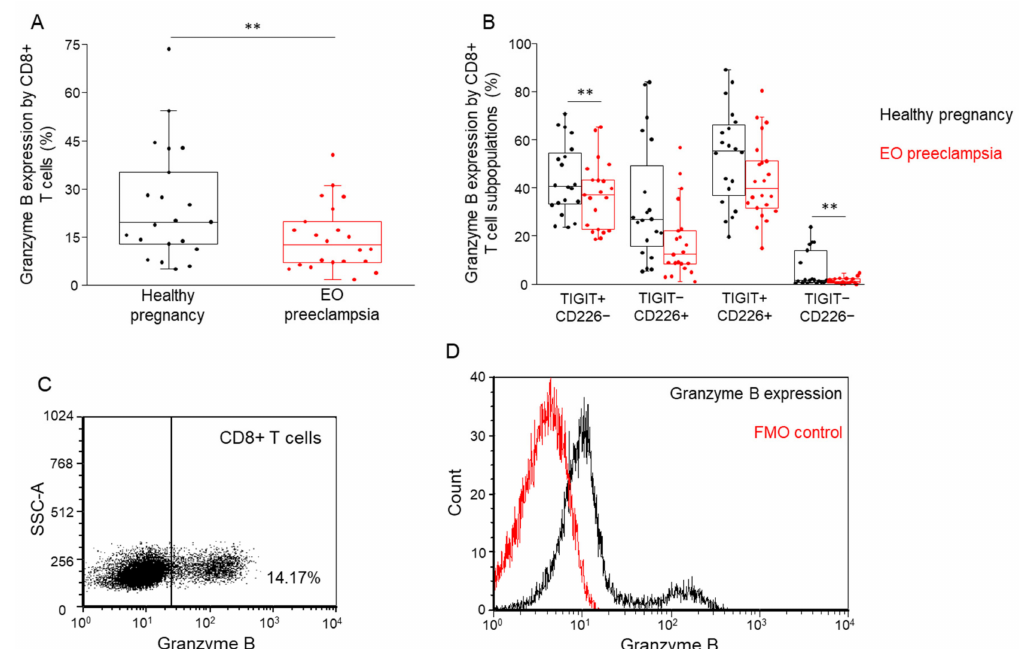
Figure 6. Granzyme B expression by the CD8+ T cell subpopulations in women with EO preeclampsia and healthy pregnant women. The intracellular expression of granzyme B molecule by CD8+ T cells in the peripheral blood of women with EO preeclampsia and healthy pregnant women ( A ). Granzyme B expression by CD8+ T cell subpopulations is based on the surface presence or absence of the TIGIT and CD226 receptors in women with EO preeclampsia and healthy pregnant women ( B ). The solid bars represent medians of 21 and 22 determinations, respectively, the boxes indicate the interquartile ranges, and the lines show the most extreme observations. Differences were considered statistically significant for p -values < 0.05 **. Representative FACS plots show the intracellular expression of granzyme B by CD8+ T cells ( C ). To determine the positivity of granzyme B, FMO control was used ( D ).